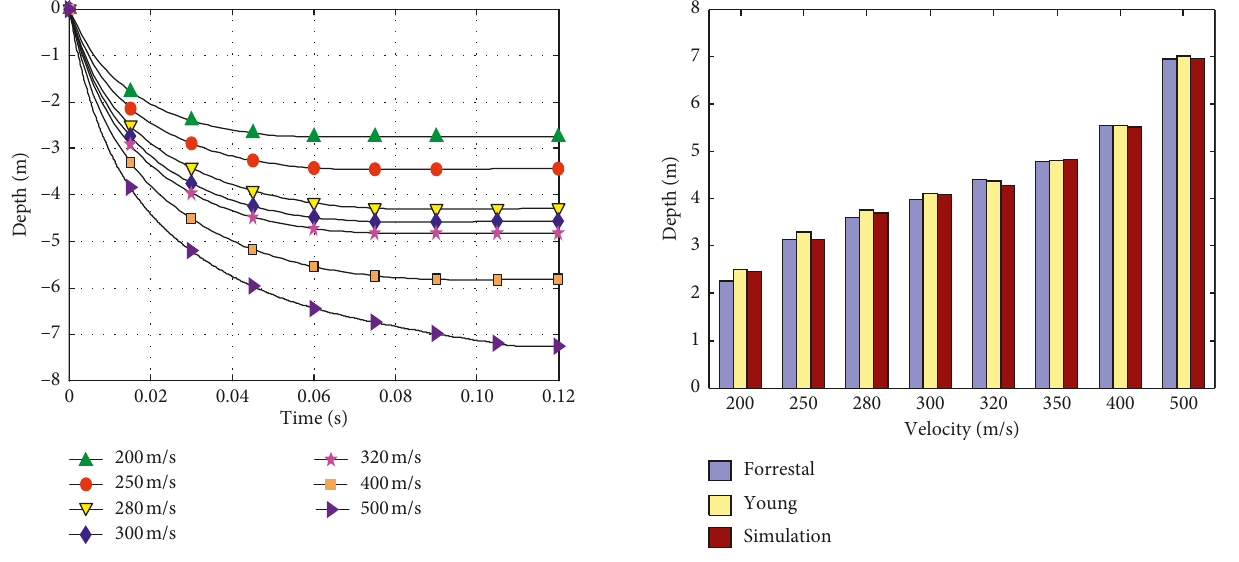
Figure 16: Penetration curves at different speeds. Figure 17: Histogram of error